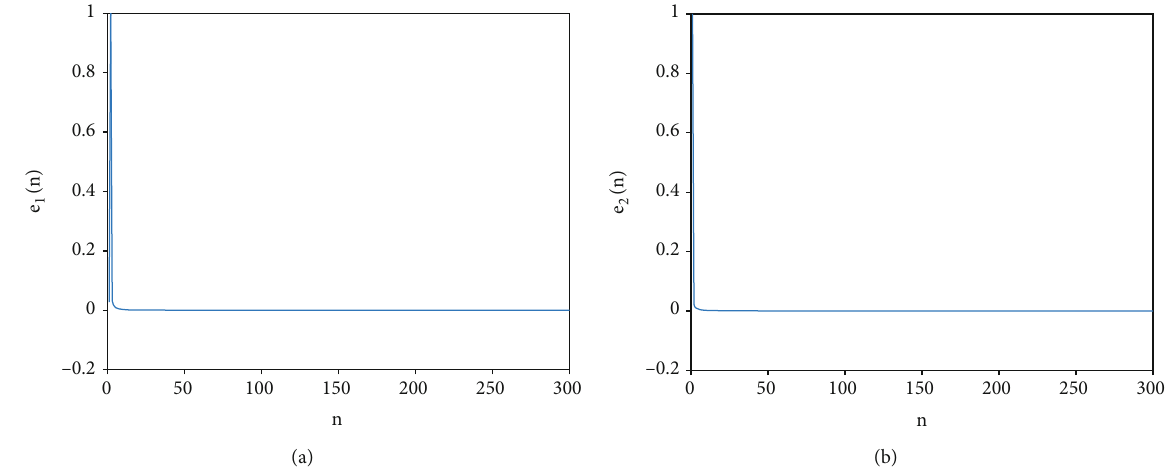
Figure 9: The synchronization results. (a) e